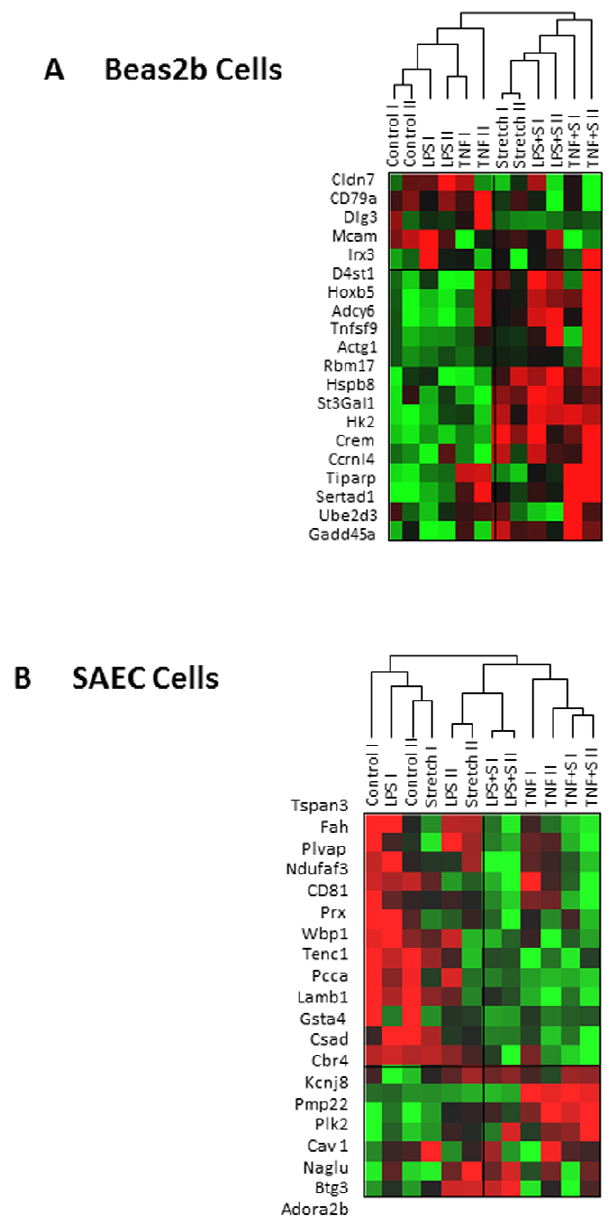
Figure 4. Validation using human pulmonary cells exposed to cyclic stretch with or without combined exposure with two inflammatory insults. Top 20 significantly expressed genes from one- hit model or BEAS2b (a) and two-hit model or SAEC (b) were mapped to the external gene expression data of human pulmonary cells. Unsupervised hierarchical clustering was used to cluster the data (Red, up-regulated in HV; green, down-regulated in HV). The top 20 genes from the meta-analysis identified group assignment correctly for all cross-validation in the training group. Through 20 randomly partitions of the 50 samples into training and test groups, differentially regulated genes from the two-hit model were able to predict PGF with an average accuracy of 82.4% in the training group and 71.3% in the test group. In contrast, genes from the one-hit model predicted PGF with an average accuracy of 88.9% in the training group and 77.6% in the test group. Therefore, both of our selected gene lists gave fairly good predictions of PGF.